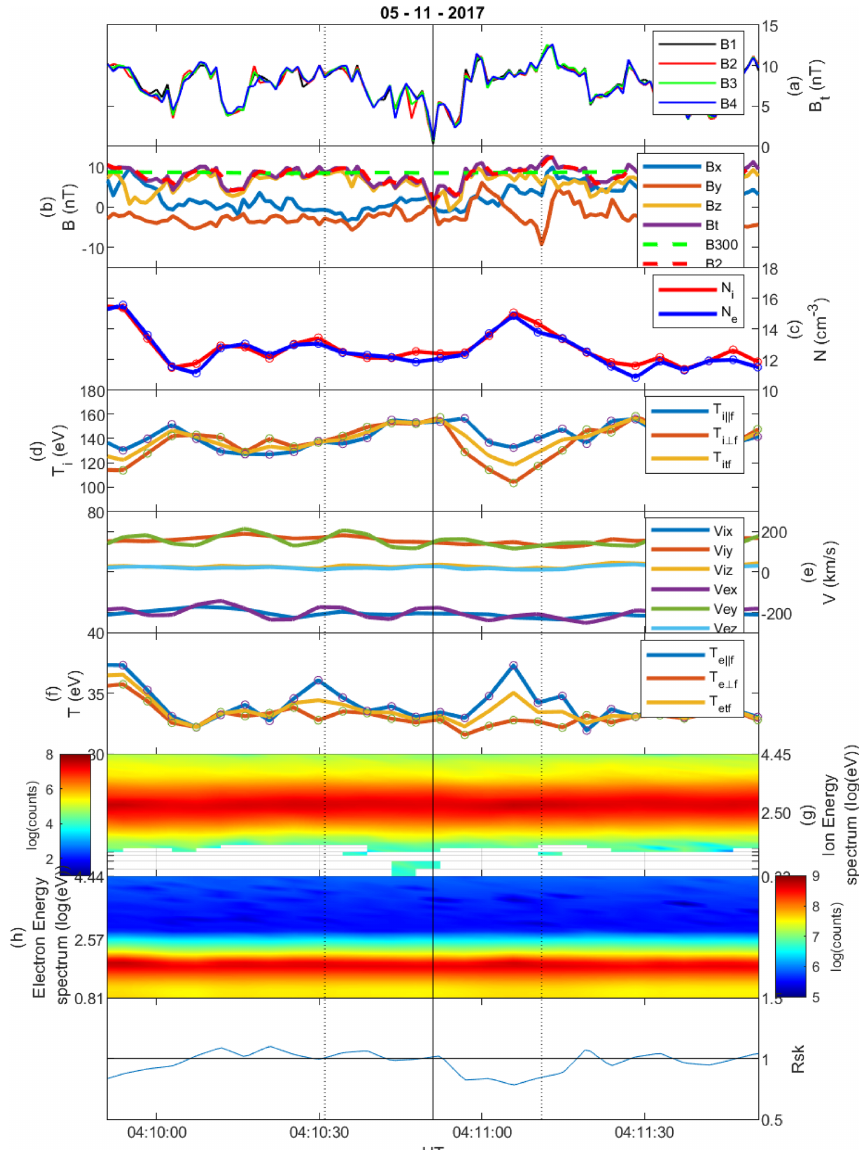
Figure 9. Linear magnetic hole structure on 5 November 2017, category sign change. Format as in Fig.